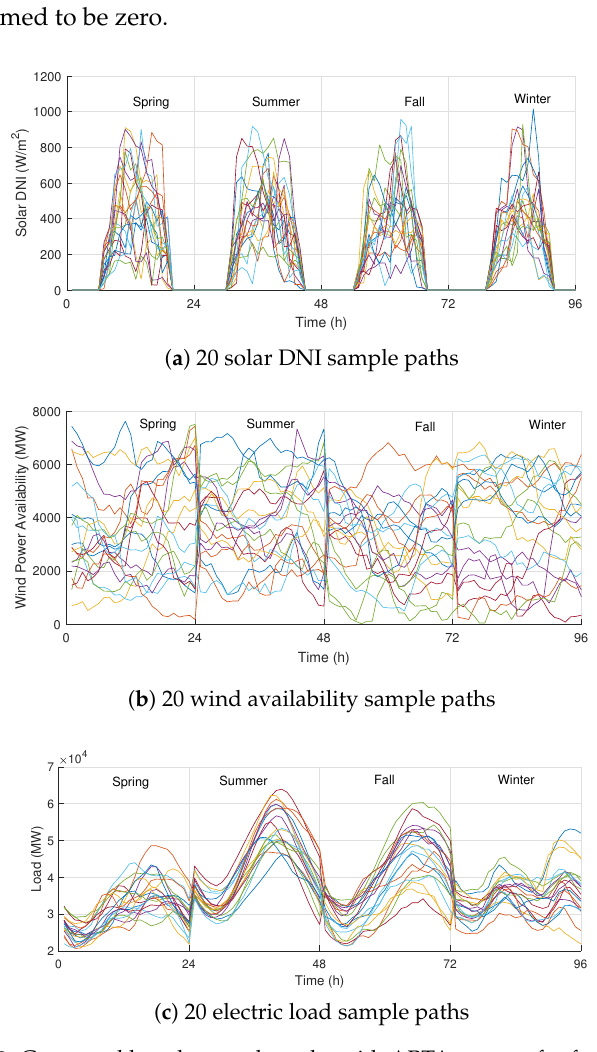
Figure 2. Generated hourly sample paths with ARTA process for four